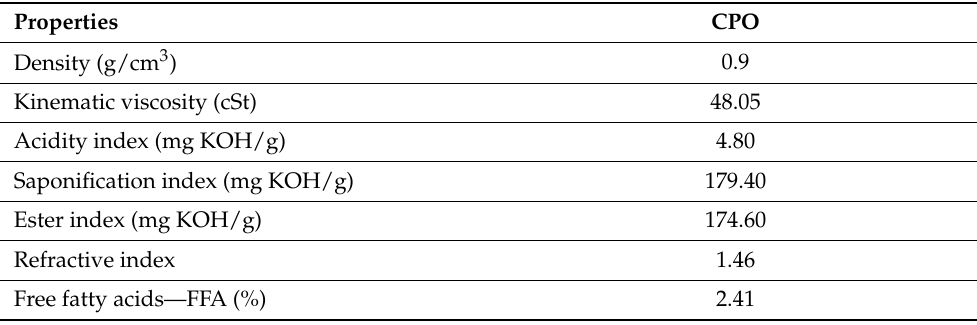
Table 2. Physicochemical characterization of crude palm oil (CPO) used as raw renewable material by thermal–catalytic processes at pilot scale